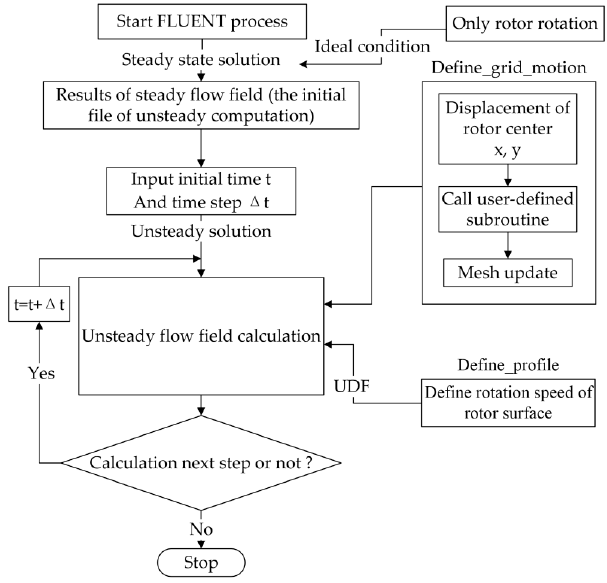
Figure 6. Calculation flow chart of the proposed transient CFD method.